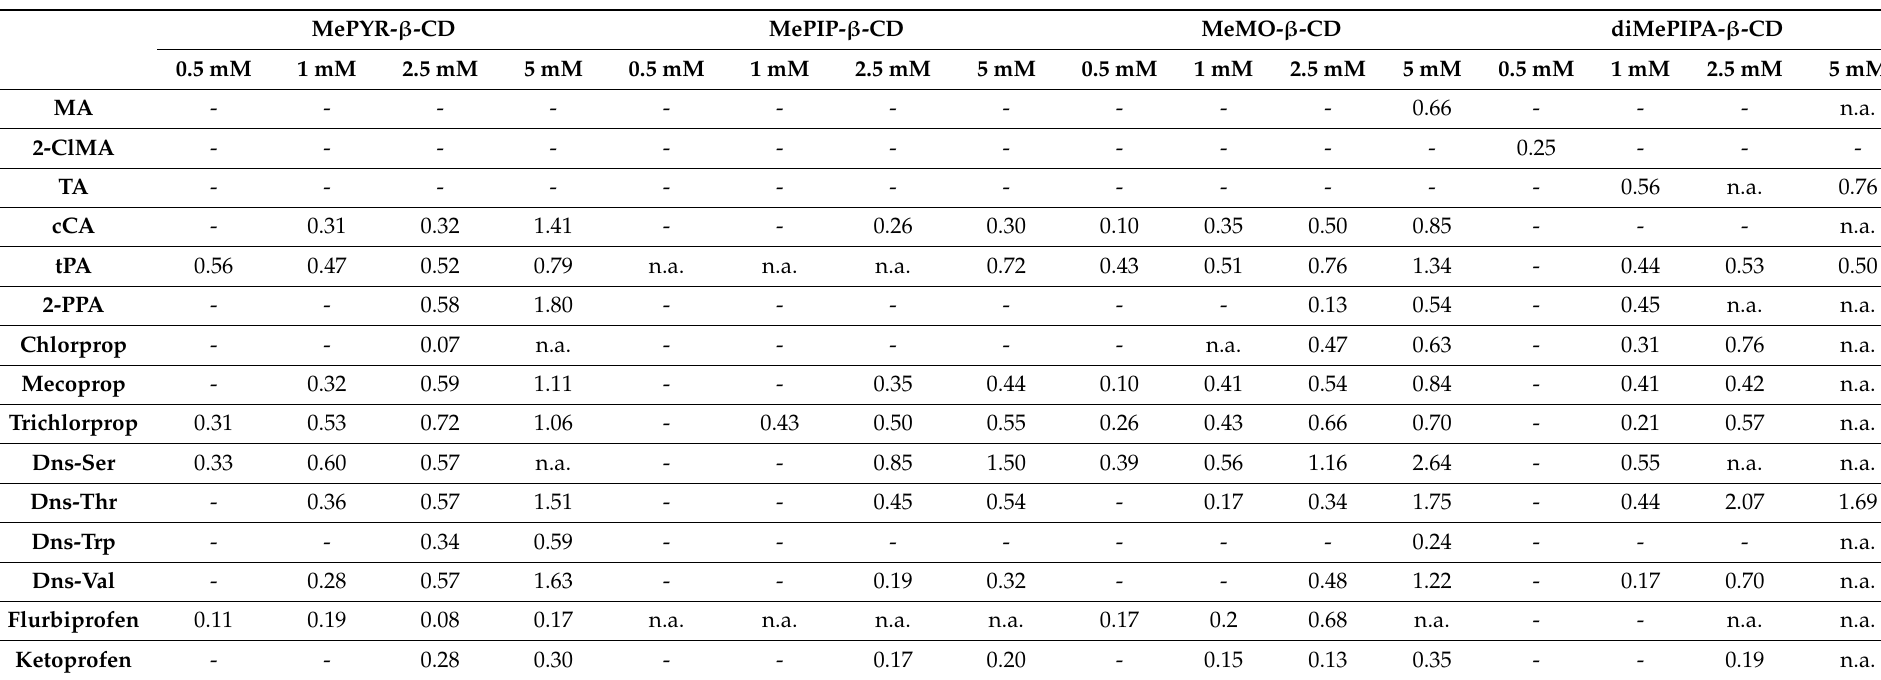
Table 4. Chiral separations of the tested model racemates with the four permanently positively charged N -heterocyclic CD derivatives (second set) at pH 10.0, indicating the maximum resolution values ( Rs